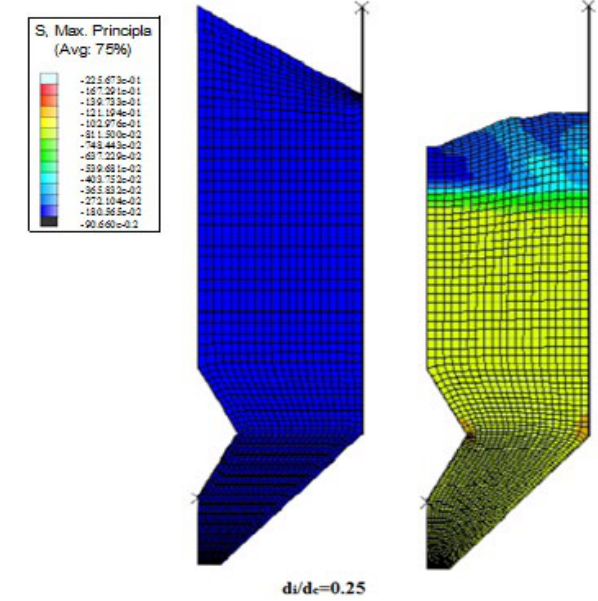
Figure 20: Adaptive grid deformation over time of flow state without Figure 20 : Adaptive grid deformation over time of flow state without the use of insert the use of Figure 19: Silo model with insert Figure 19: Silo model with insert Figure 19: Silo model with insert.